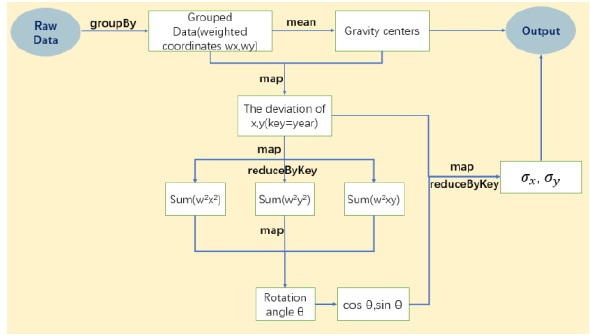
Figure 2. Data Flow of the computation of SDEs and gravity